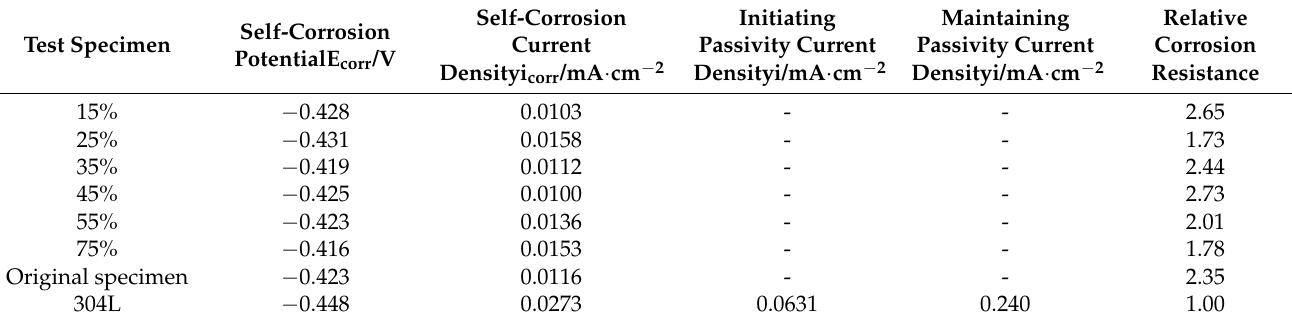
Table 2. Electrochemical corrosion test results of different specimens in a 3.5% NaCl Solution.